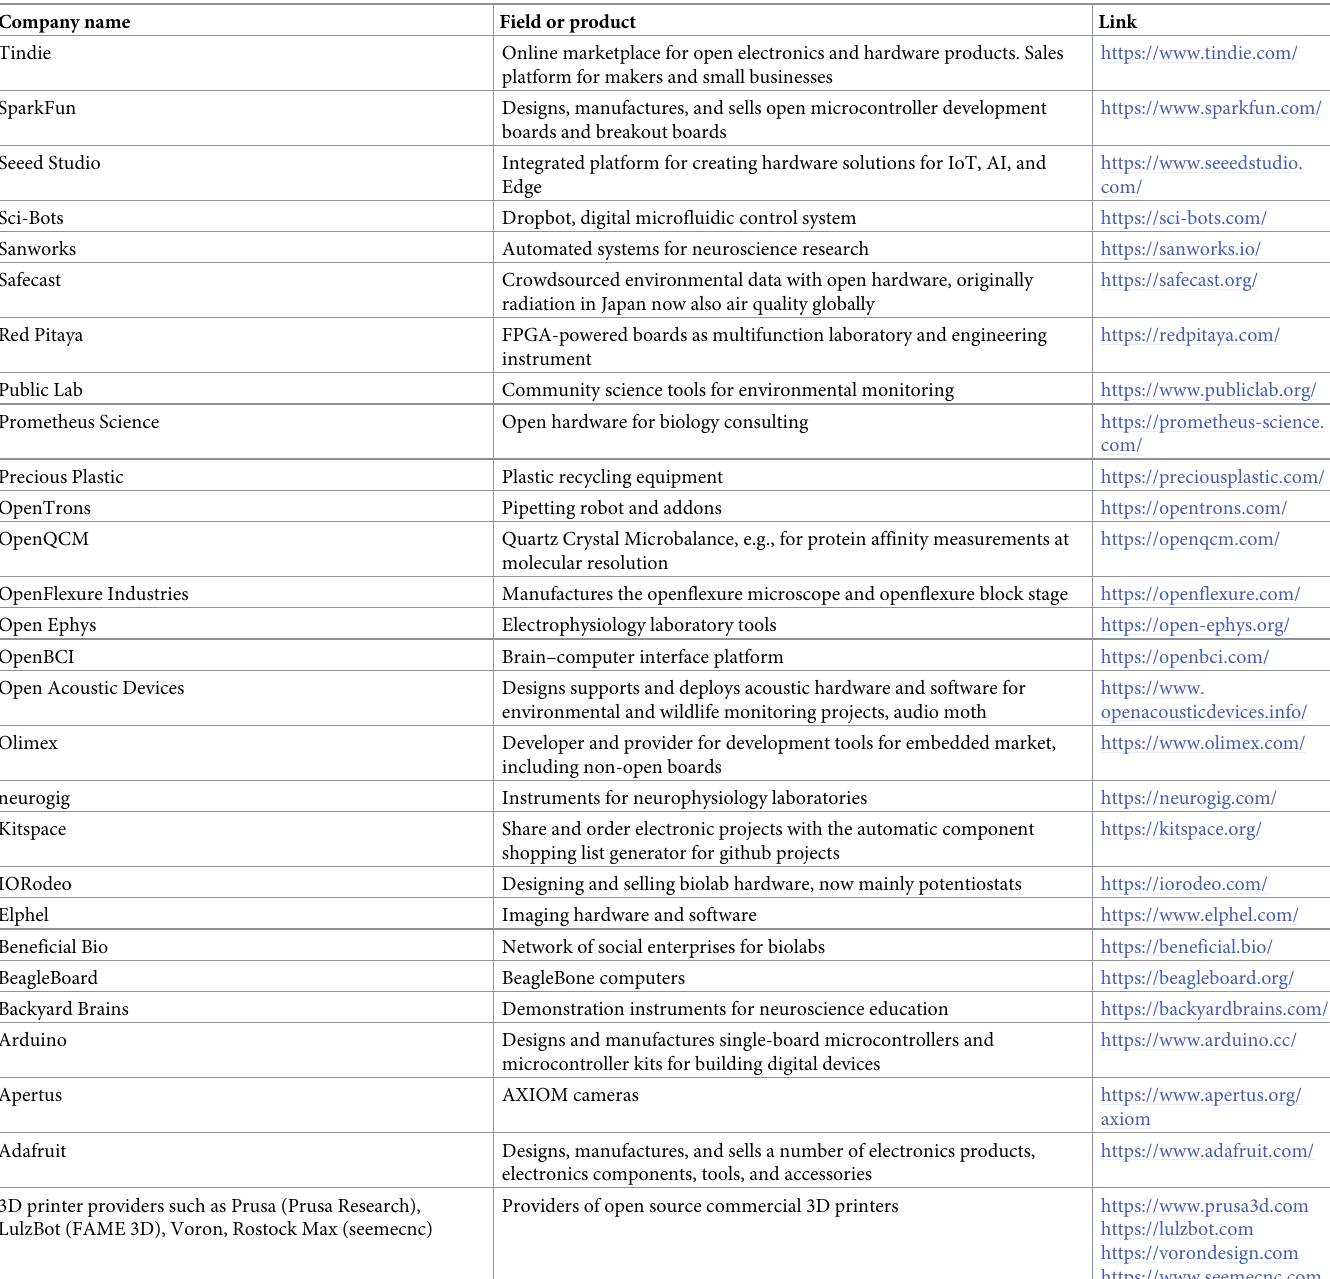
Table 1. Examples of open hardware companies relevant for biology